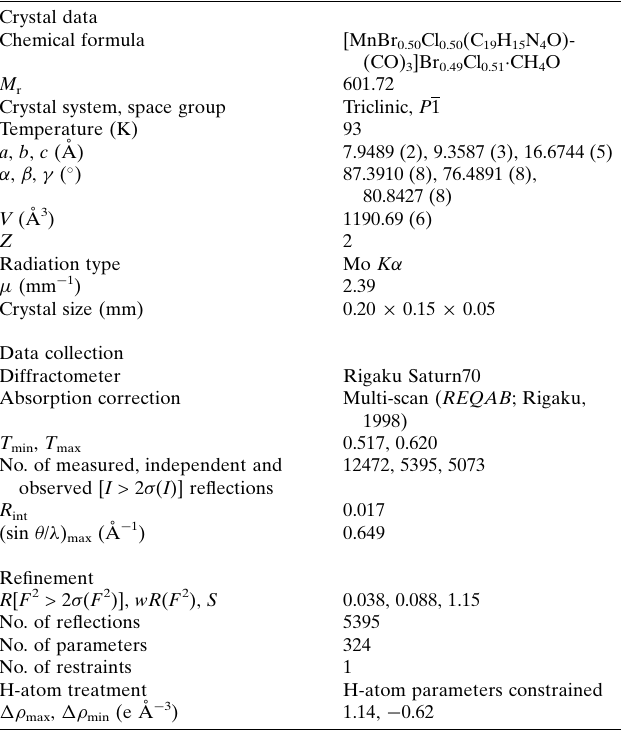
Table 2 Experimental details. Crystal data Chemical